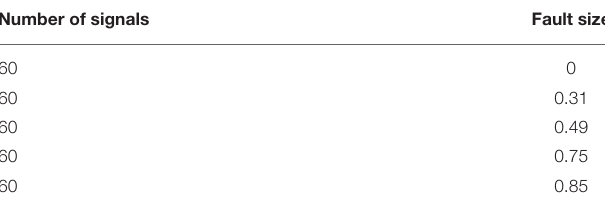
TABLE 1 | Table of fault